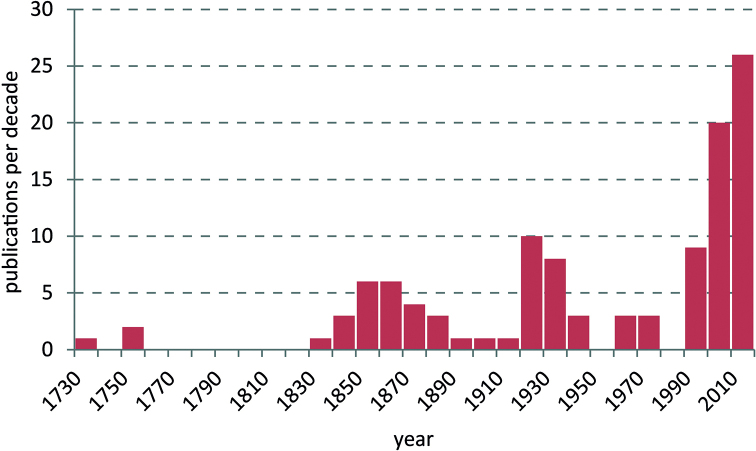
Number of publications on Norwegian sciarid fauna per decade between 1730 and 2020.